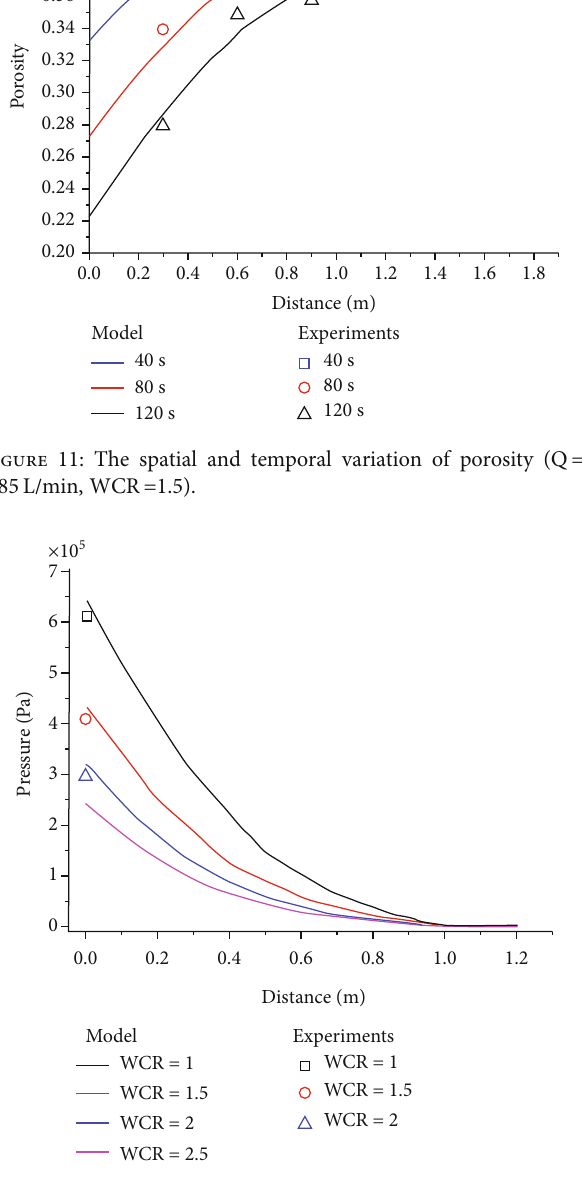
Figure 12: The variation of grouting pressure versus the di ff usion distance ( Q = 2 : 85L/min , t = 60s ).